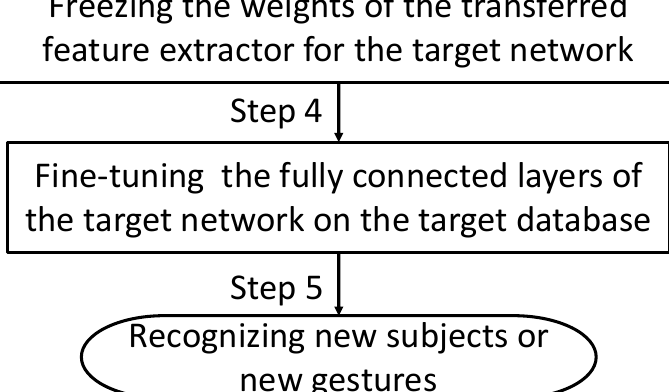
Figure 3. The training process of the target network. The first step is to train the source network on the source database. Then, in step two, the well-trained source domain feature extractor of the instantaneous classifier is transferred to the target network so that the target network could utilize source knowledge directly. In the third step, freezing the weights of the transferred feature extrator makes sure source knowledge retaining in the next step. Step four is to fine-tune the fully connected layers of the target network on the target database. And the last step is recognizing new subjects or new gestures by the target network. The architecture of the target network with the TL strategy is shown in Figure